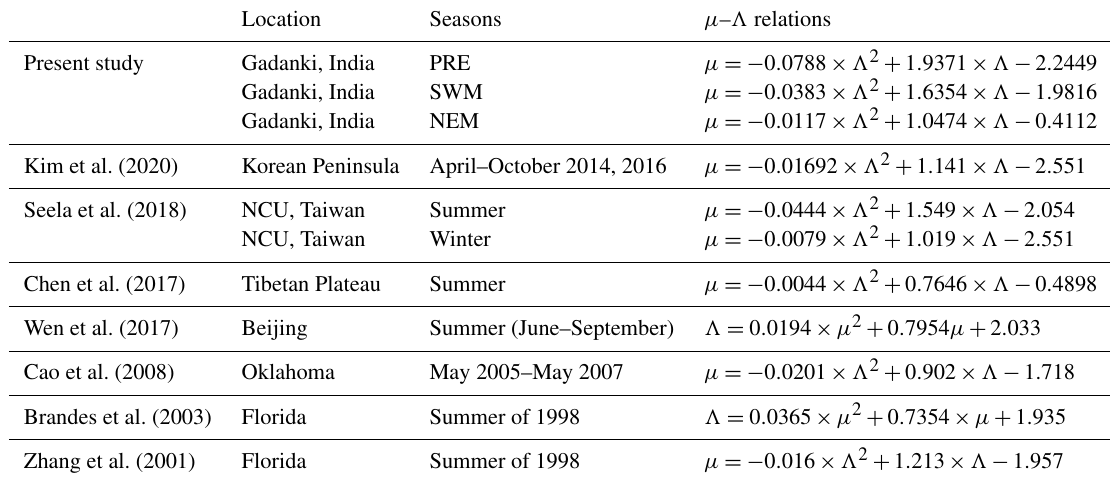
Table 2. Comparison of µ – (cid:51) relations obtained at Gadanki with those reported elsewhere.